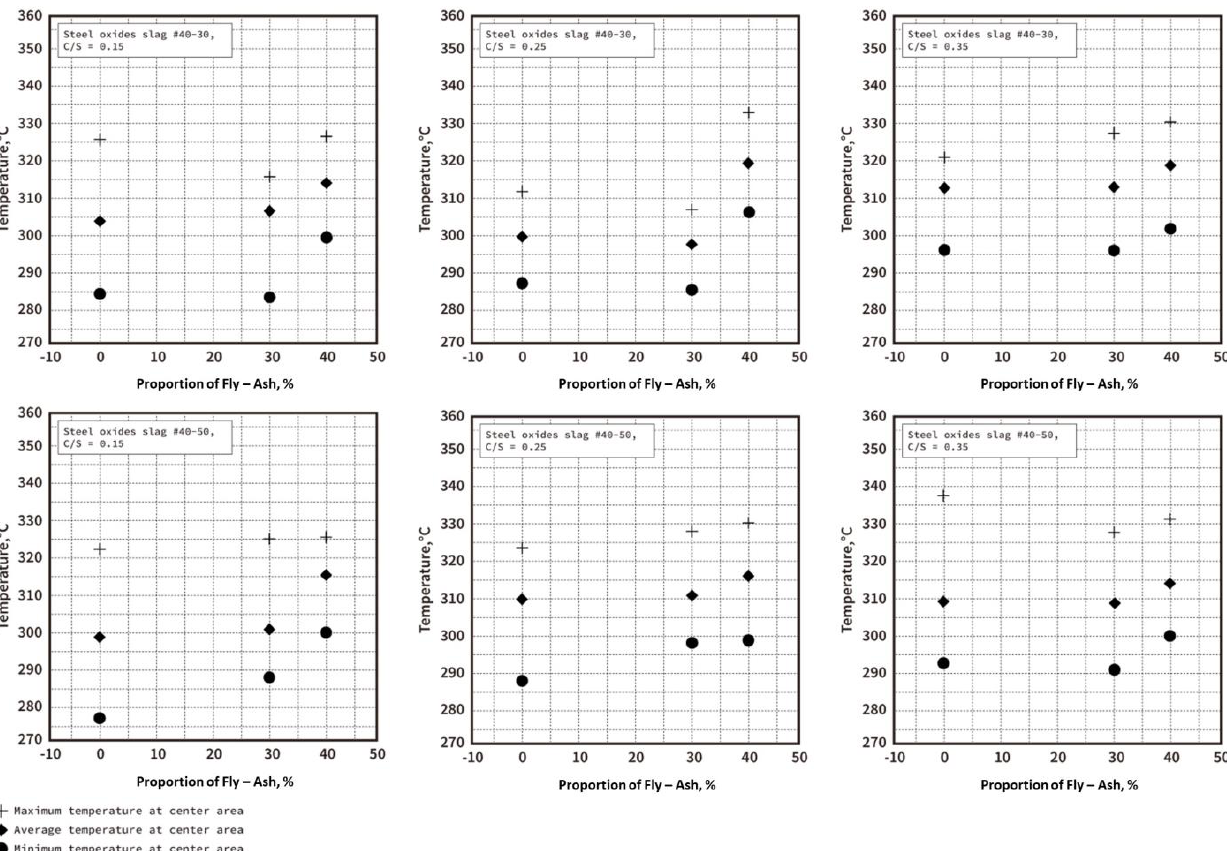
Figure 11. Temperature distribution of the EAF oxidizing slag specimens in three ratio settings.